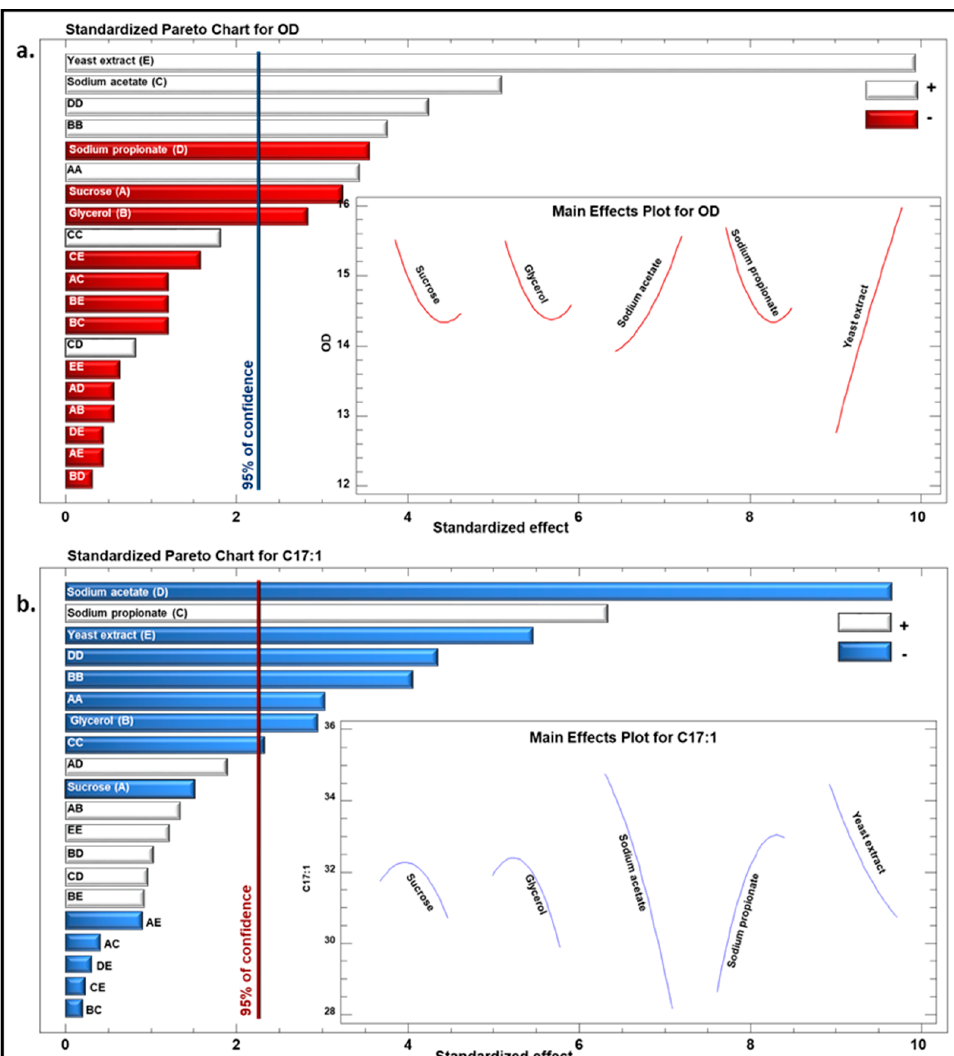
Figure 2. Standardized Pareto chart for OD 600nm ( a ) and for % of C17:1 ( b ). Vertical lines indicate statistically significant parameters with more than 95% confidence. (+) indicates positive effect, (-) indicates negative effect. Inserts show the variation of response parameters, OD 600nm ( a ) and % of C17:1 ( b ), as a function of each ingredient.